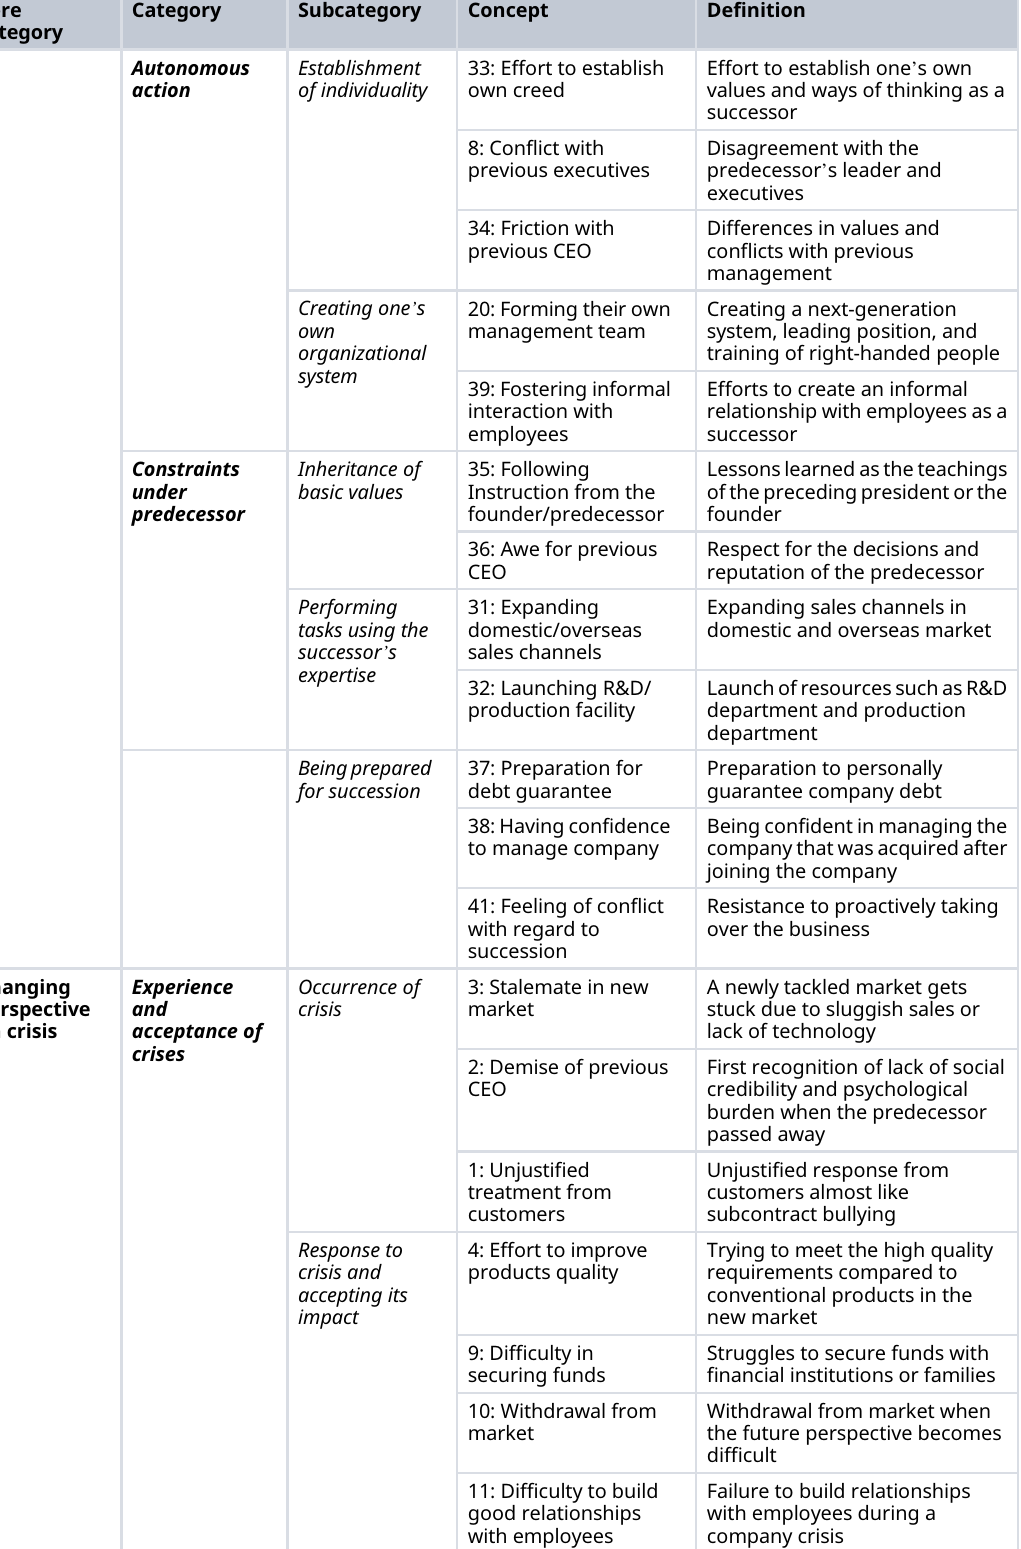
Table 4. Extracted core category, subcategory, category, and concept with their definitions. Core